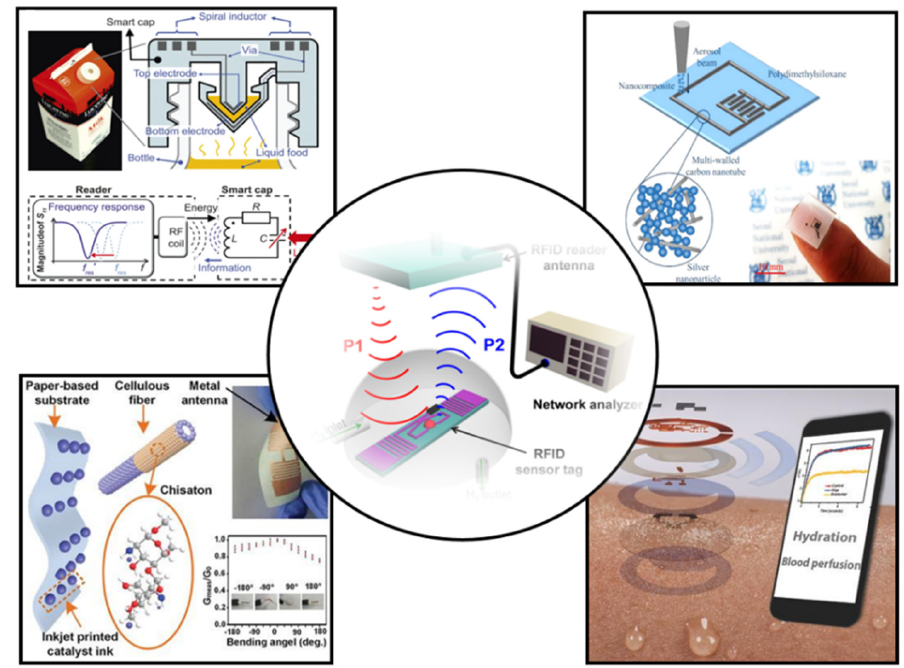
Figure 2. Recent progress in NFC and RFID sensors [12–16]. Reprinted with permission from Ref.